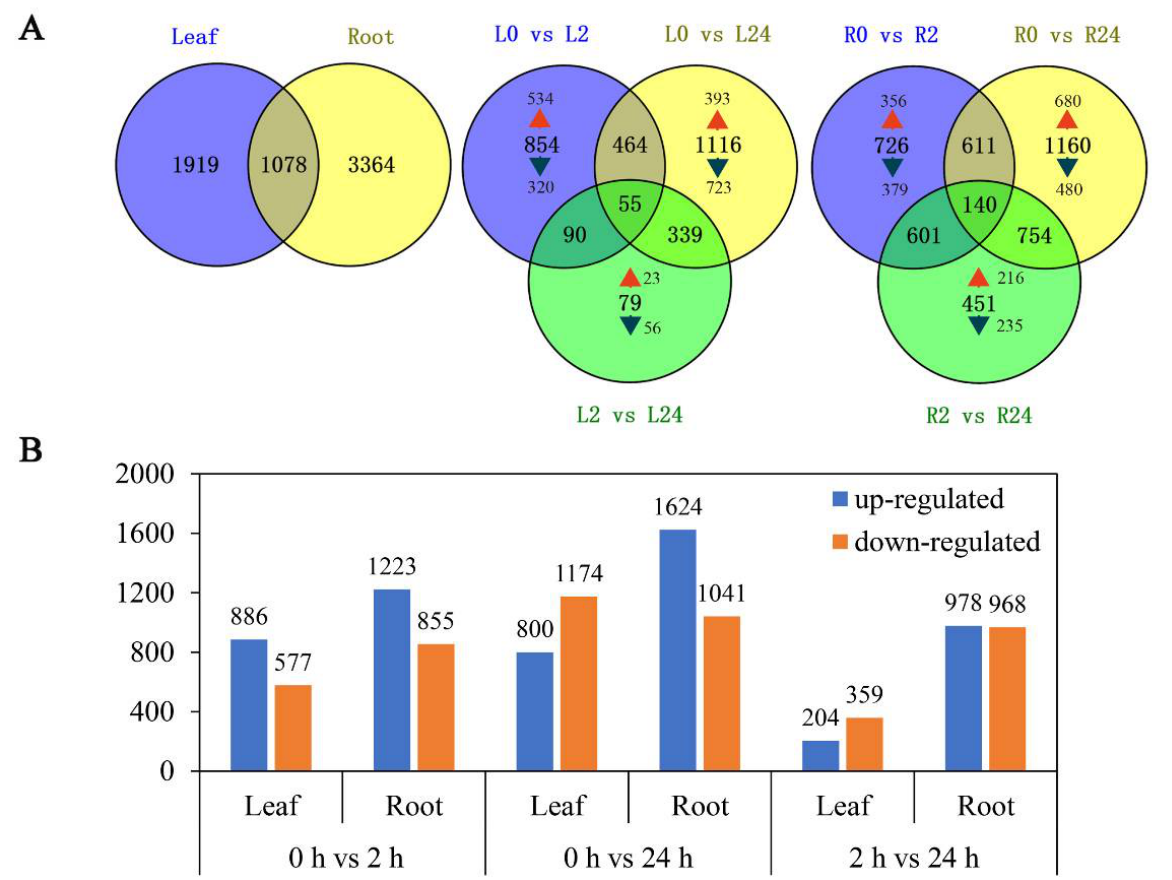
Figure 3. Summary of differentially expressed genes. ( A ) Summary of the numbers of root and leaf differentially expressed genes (DEGS) at different duration of salinity treatment. ( B ) Number of genes whose expression is differentially regulated between the different conditions. Orange bar: down-regulated genes; blue bar: up-regulated genes.